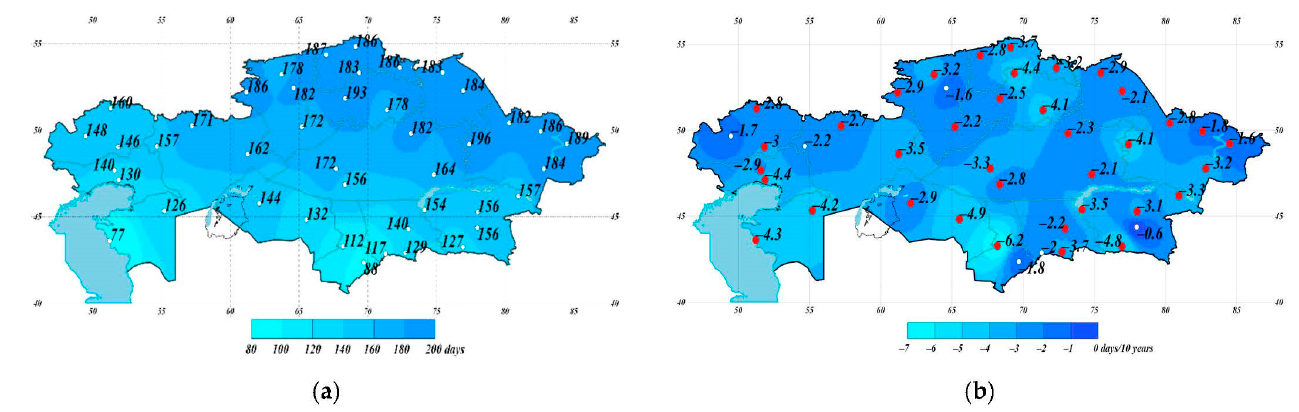
Figure 2. Spatial distribution of the number of days with minimum daily temperature < 0 °C (FD) ( a ) and trends of this parameter ( b ) for the period 1971–2020.